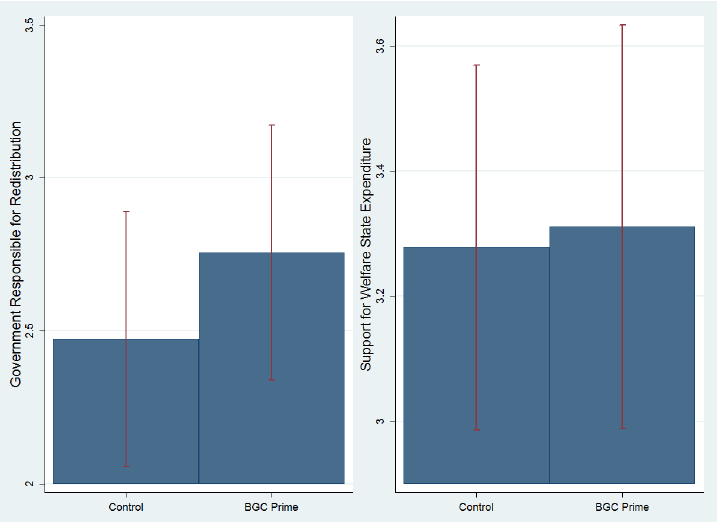
Fig 2. The Effect of the BGC Question Order Prime on Support for Redistribution and Support for Welfare State Expenditure among American Jews (Study 2). The graphs include 95% statistical significance